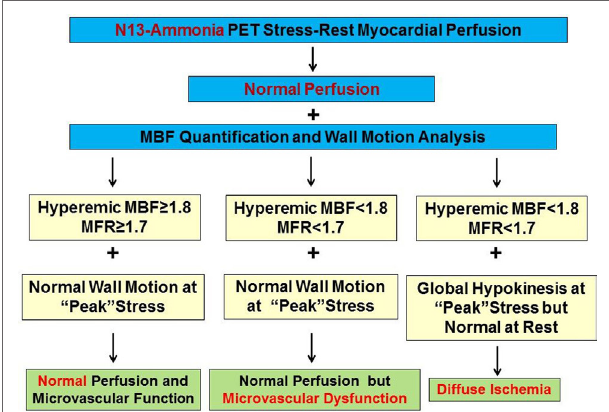
FiGURe 8 | Algorithm for the integration of 13 N-ammonia positron emission tomography/computed tomography perfusion images, myocardial blood flow (MBF), and wall motion analysis for differentiation between microvascular dysfunction and diffuse ischemia. Evaluating hyperemic MBFs in conjunction with wall motion analysis at “peak” stress affords the differentiation between predominant microvascular dysfunction and diffuse myocardial ischemia caused by significant left main and/or three vessel CAD. Balanced reductions in hyperemic MBFs and normal wall motion of the left ventricle (LV) at peak stress favors the presence of predominantly microvascular disease but not diffuse ischemia, whereas diffuse reductions in hyperemic MBFs associated with transient ischemic cavity dilation of the LV during vasomotor stress identifies the presence of diffuse ischemia [reproduced with kind permission from Schindler et al. (1)].